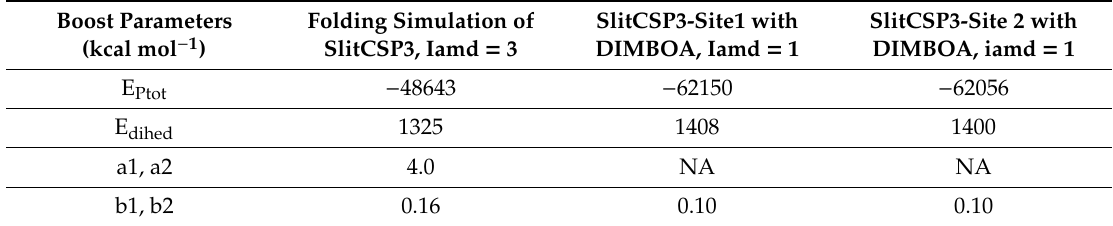
Table 2. The values of total potential energy, dihedral energy, their respective boost parameters b1, b2 and a1, a2 applied for aMD